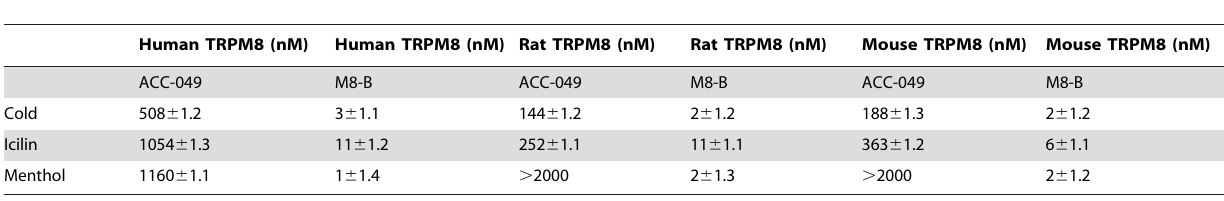
Table 2. IC 50 values (nM) of cold, icilin, and menthol induced human, rat, or mouse TRPM8 channel activation by ACC-049.